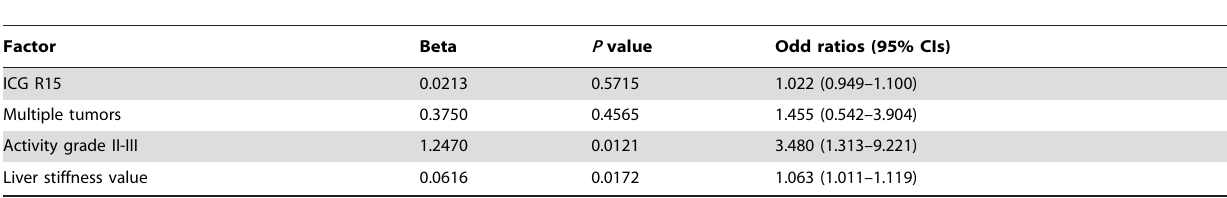
Table 2. Multivariate analysis to identify independent predictors ofHCC